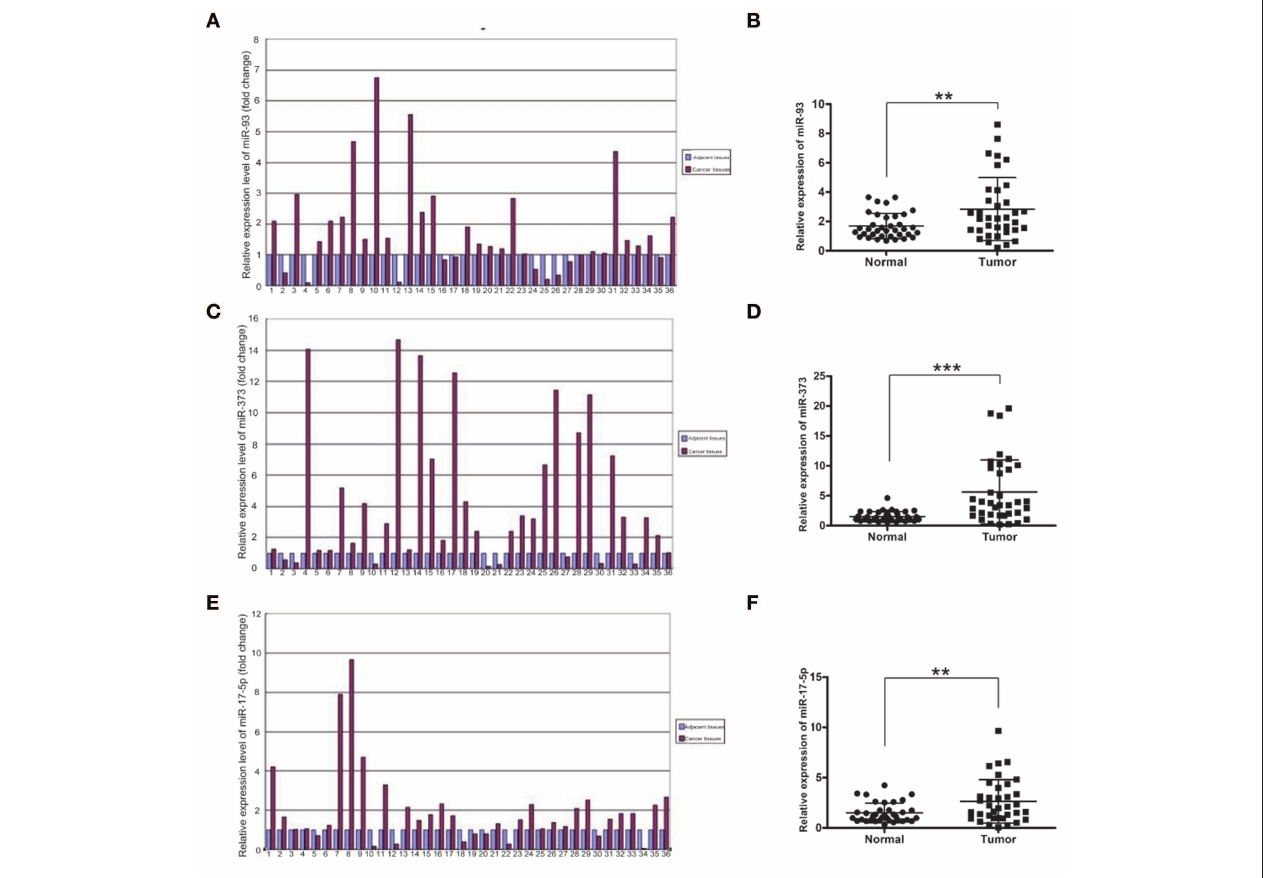
FIGURE 1 | The mRNA levels of miR-93, miR-373, and miR-17-5p in lung cancer tissues. (A,B) The mRNA level of miR-93 in lung cancer tissues and adjacent non-cancerous tissues of 36 patients ( n = 36, ** P < 0.01, two-tailed unpaired Student’s t test). (C,D) The mRNA level of miR-373 in lung cancer tissues and adjacent noncancerous tissues of 36 patients ( n = 36, *** P < 0.001, two-tailed unpaired Student’s t test). (E,F) The mRNA level of miR-17-5p in lung cancer tissues and adjacent noncancerous tissues of 36 patients ( n = 36, ** P < 0.01, two-tailed unpaired Student’s t